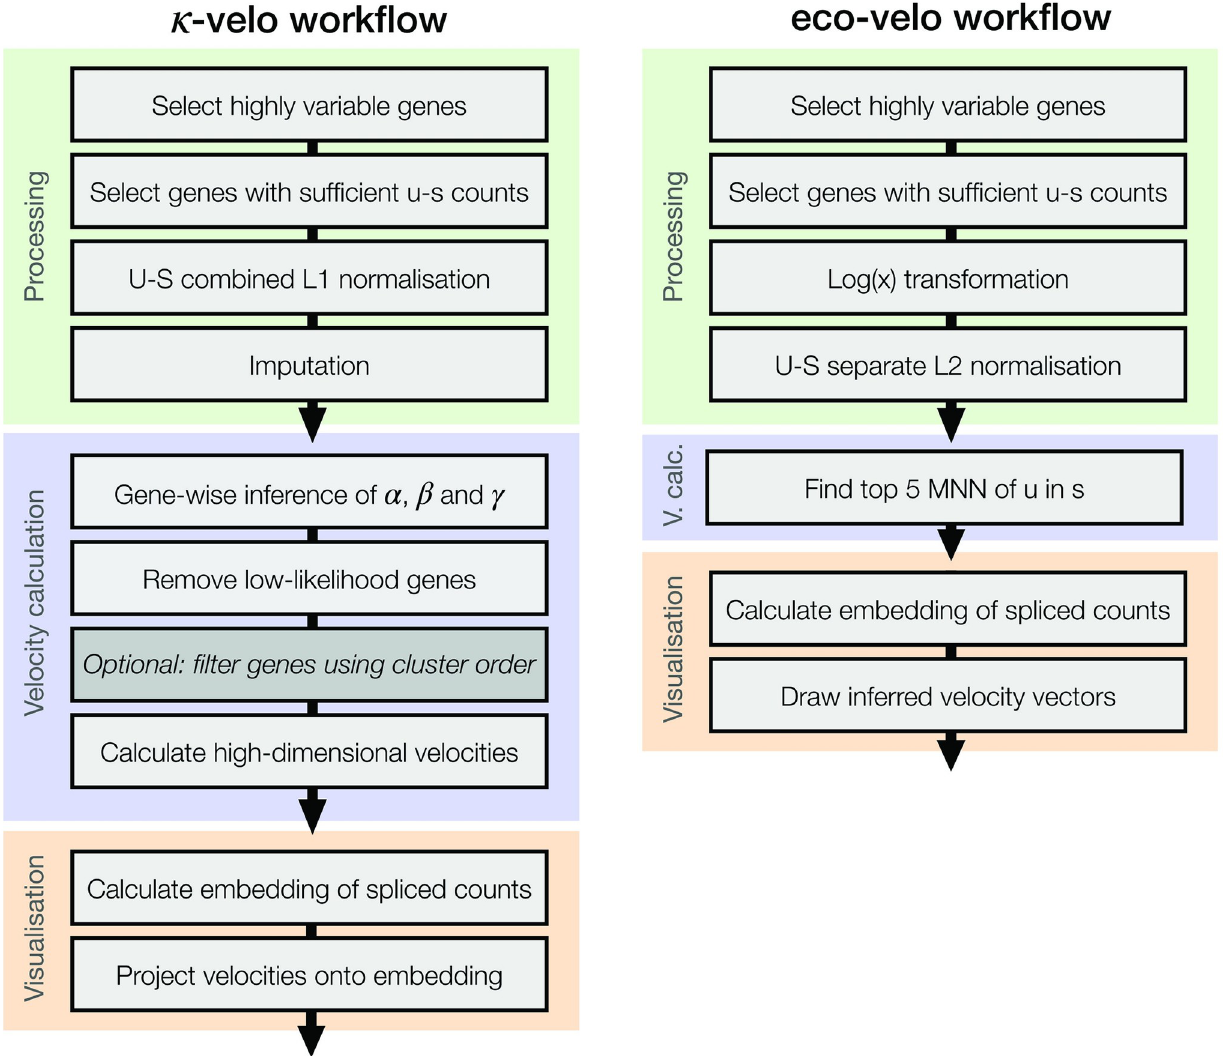
Fig 1. An overview of RNA velocity analysis steps in the κ -velo and eco-velo workflow.